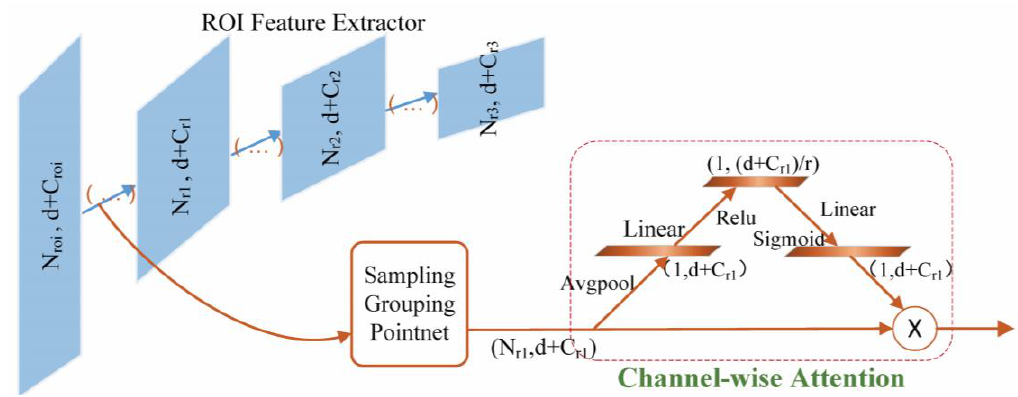
Figure 7. Architecture of our region of interest (ROI) feature extractor with the proposed channel-wise attention (CA) modules.